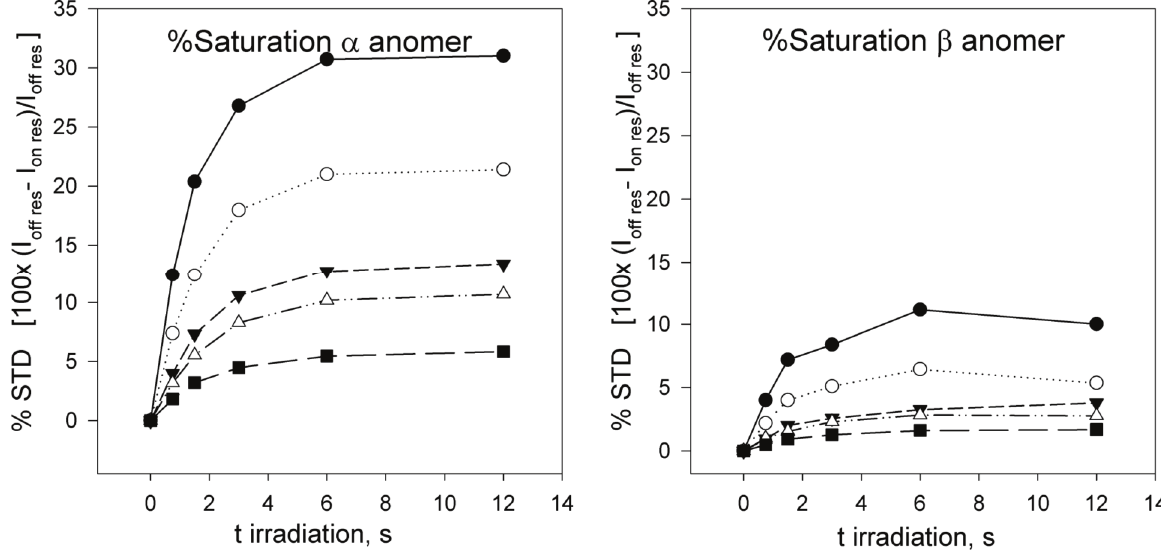
Figure 3. % STD build-up curves obtained at 290 K for (cid:3)-2FDM ( left ) and (cid:5)-2FDM ( right ) in the presence of ConA (90 μM) at several total concentrations of monosaccharide 0.96 ((cid:8)); 1.94 ((cid:9)); 4.14 ((cid:10)); 5.57 ((cid:11)); and 12.1 mM ((cid:12)) (anomer percentages 66% (cid:3)-2FDM and 34% (cid:5)-2FDM). The representation of 19 F STD intensity versus saturation time shows that a stationary state, where saturation is compensated by relaxation, is reached at an approximate spin irradiation time of 6